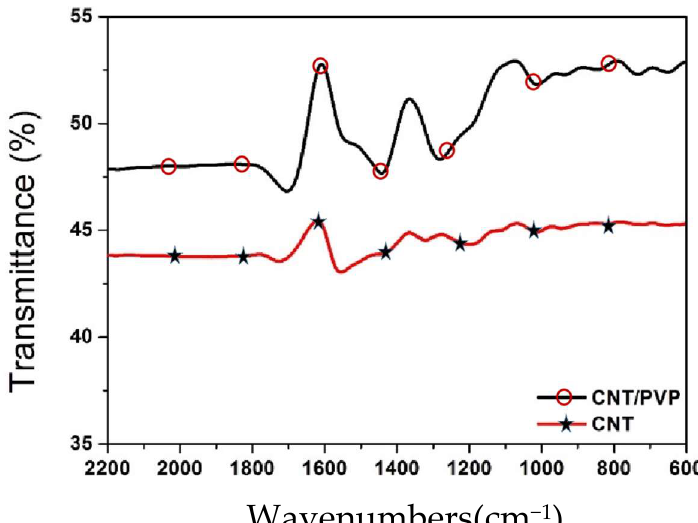
Figure 7. FTIR spectra of modified CNT/PVP.